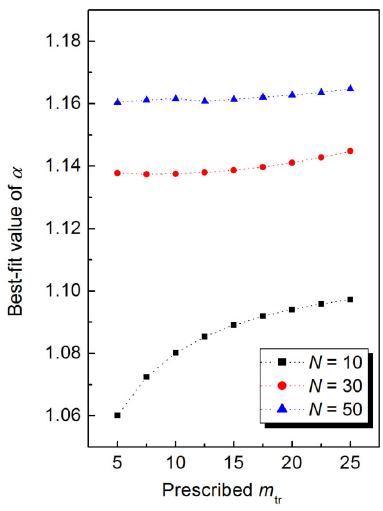
Fig. 2 Best-fit value of  as a function of the prescribed m tr